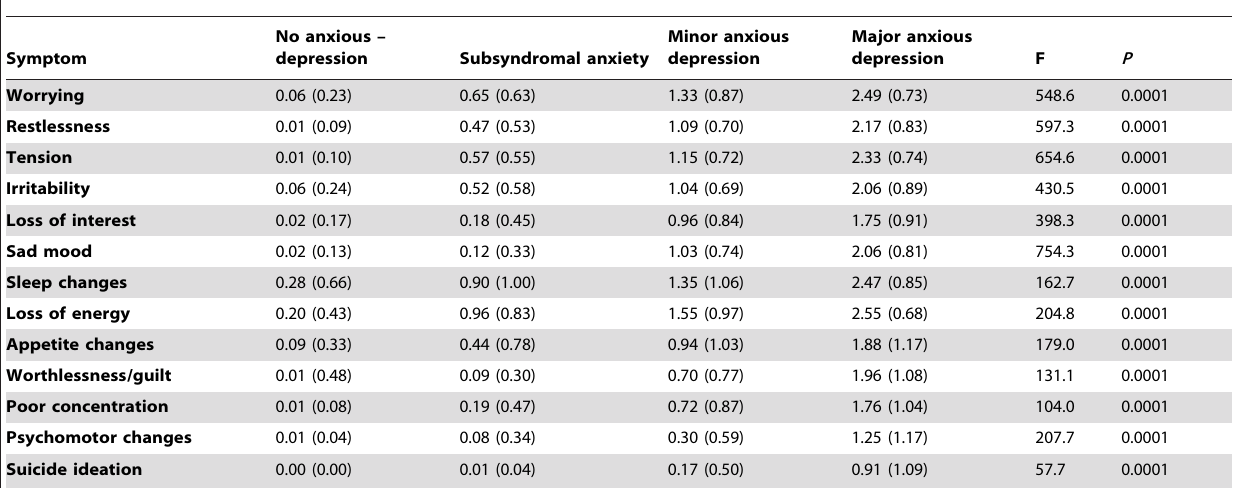
Table 3. Scores for anxiety and depression items for the four LCA